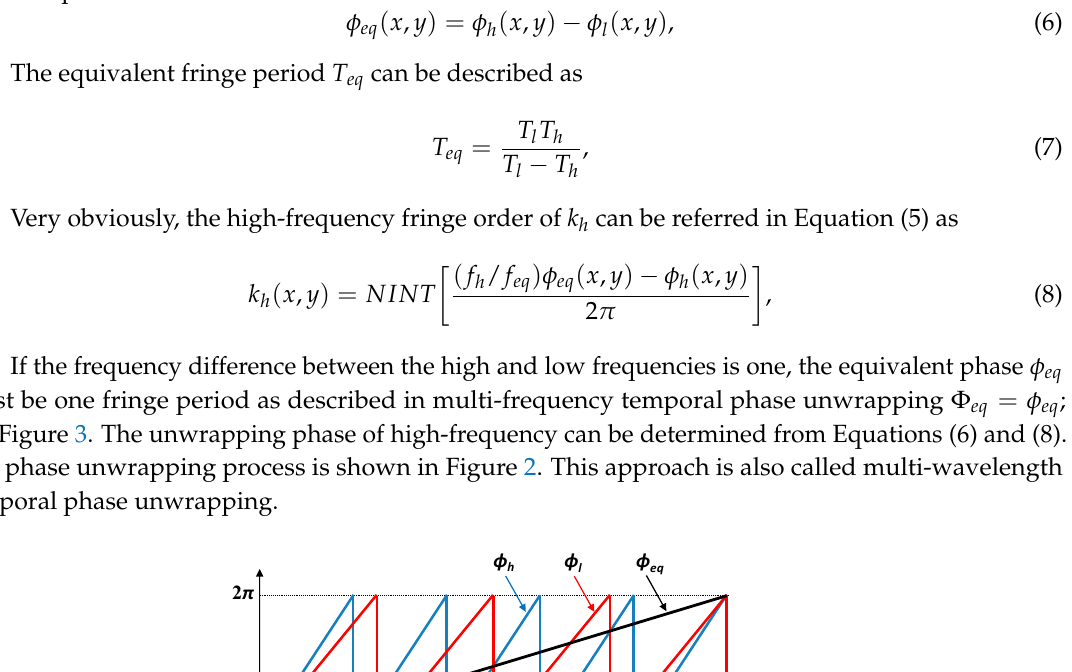
φ and φ calculation as the difference between l eq φ is also regarded as the eq